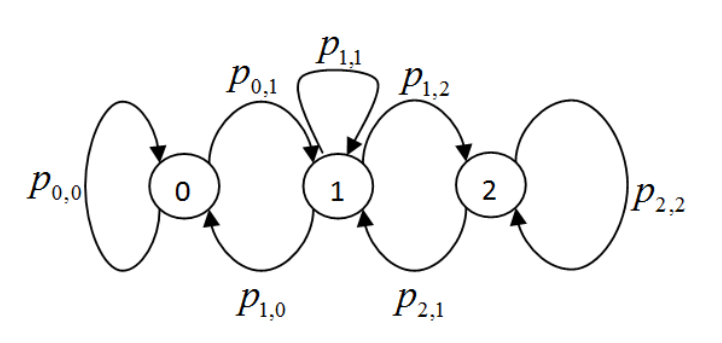
Figure 3. M/M/1/2 with one-step transition